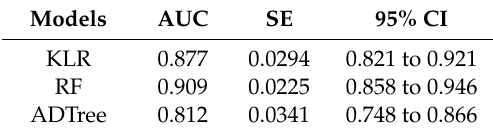
Table 5. Parameters of AUC values using training dataset. SE: standard error; CI: confidence interval.